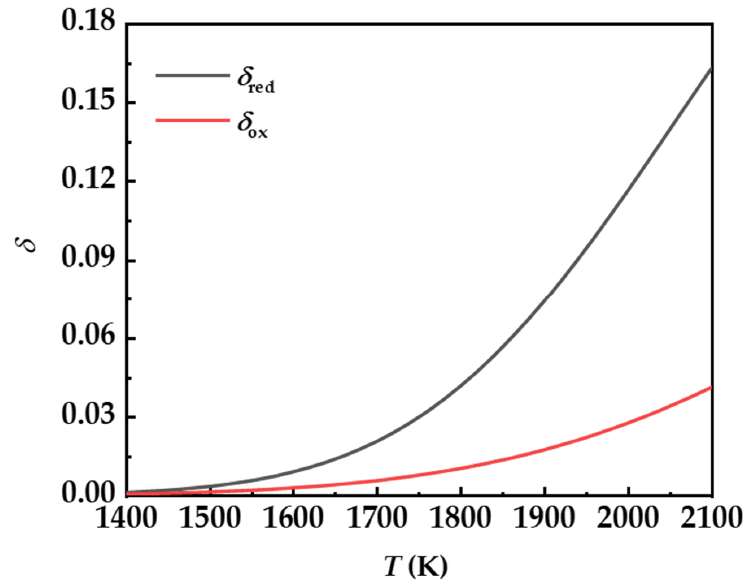
Figure 2. Nonstoichiometric coefficient, δ red , as a function of temperature, T , for a reduction with P O = 10 − 4 bar. δ ox as a function of T , for an oxidation with P CO = 200 bar.